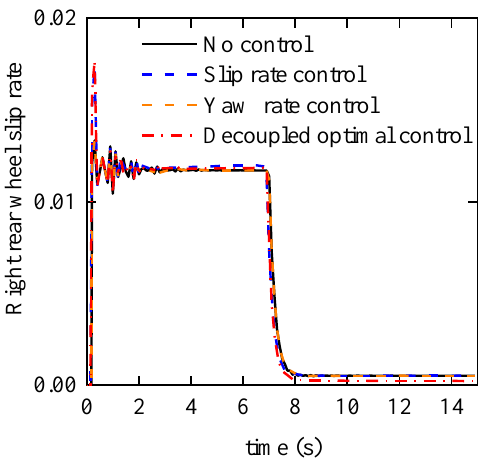
Figure 15. Right rear wheel slip rate.